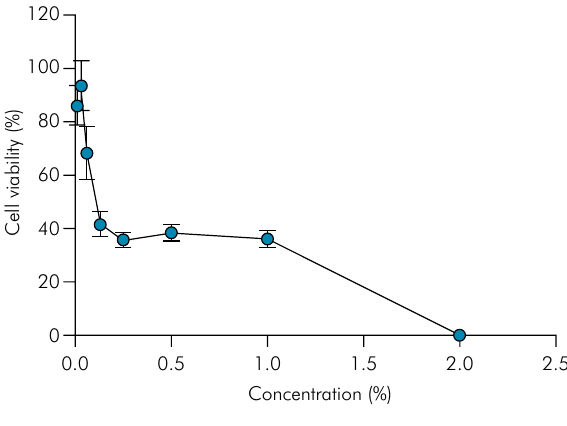
Figure 4. Mean Rhodamine 123 fluorescence in FITOPROT- treated SCC-4 cells (IC ) and control. *Statistically significant 20 difference between groups (Student’s t